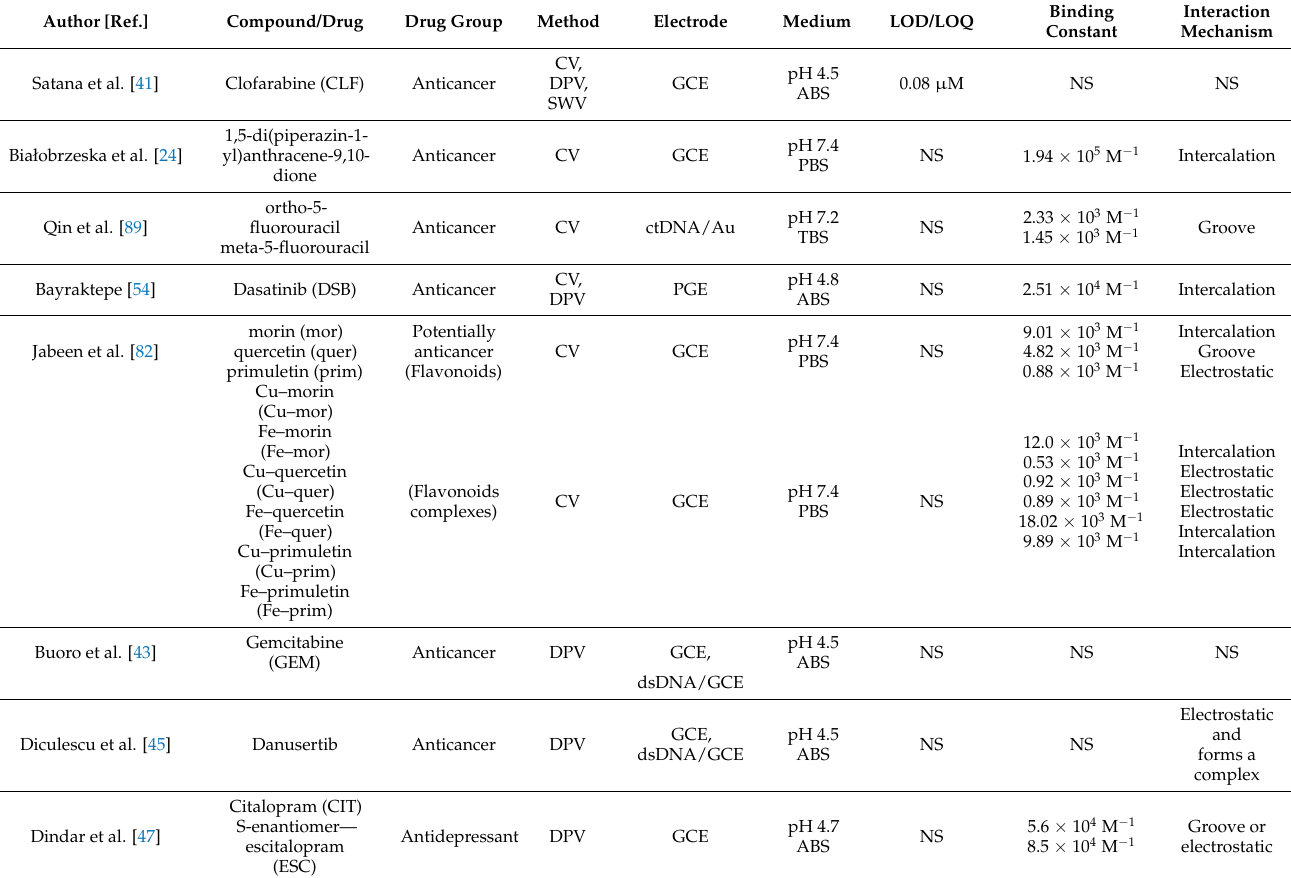
Table 1. Essential parameters of the described electrochemical research. Each column refers to: author, compound/drug studied, drug group, electrochemical method, type of electrode and medium used, respectively. Moreover, it contains the values of LOD/LOQ and the binding constant, as well as information about a suggested interaction mechanism. Author